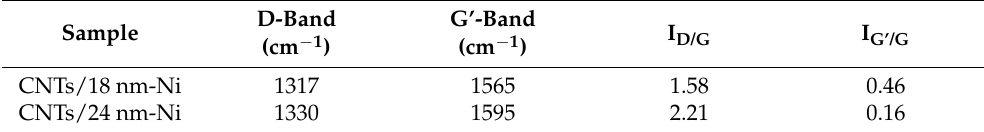
Figure 3. ( a ) Raman spectrum of the CNTs prepared with 18 and 24 nm of Ni catalyst layers, ( b ) FESEM image, and ( c ) HRTEM image CNTs prepared with 24 nm of Ni catalyst layers. Table 1. D- and G-band position, and the intensities ratios of D/G and G’/G